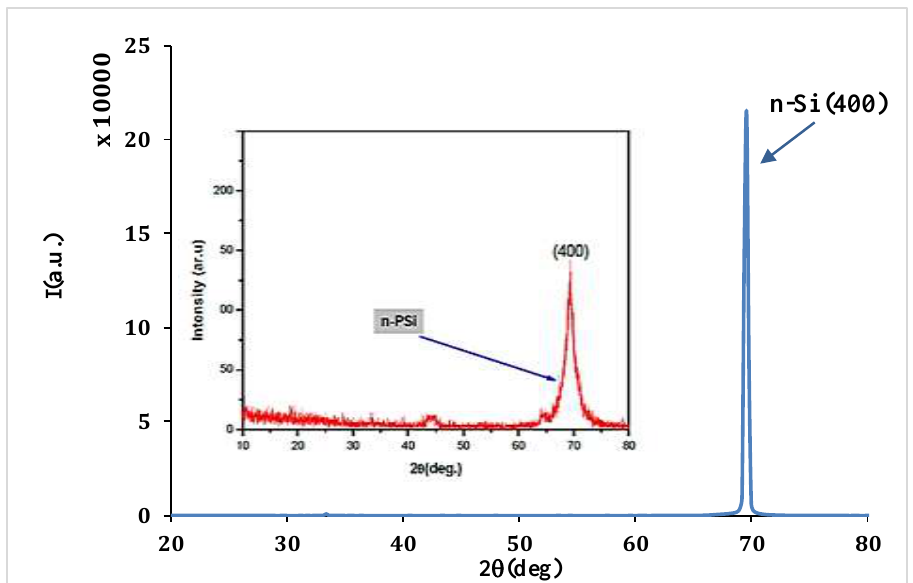
Fig.5 . XRD spectra of n-type Silicon (n-Si) and porous silicon (n-PSi) (prepared with14 mA/cm 2 etching current density at etching times 8 min) .